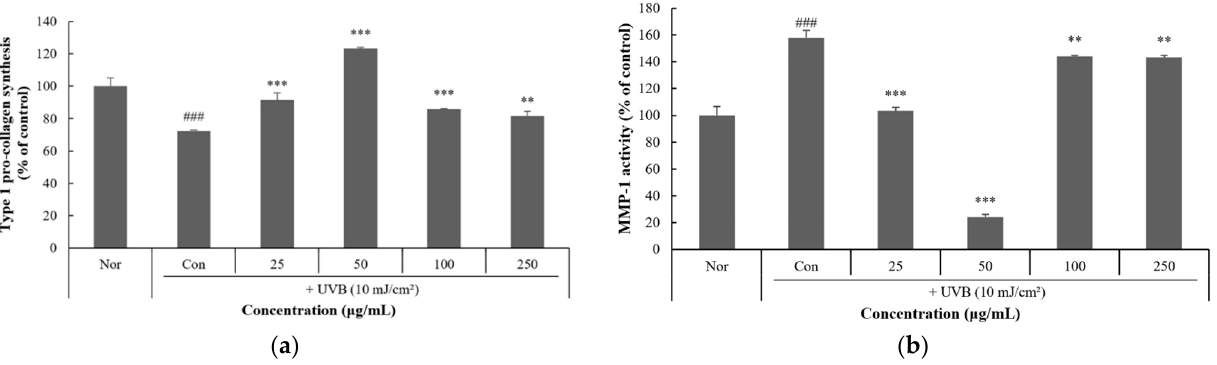
Figure 5. ( a ) Effect of P. thunbergiana L. EtOAc fraction on type-1 procollagen synthesis in UVB- irradiated (10 mJ/cm 2 ) HaCaT cells. ( b ) Effect of P. thunbergiana L. EtOAc fraction on the inhibition of MMP-1 activity in HaCaT cells. ### p < 0.001 compared with the normal control; ** p < 0.01 and *** p < 0.001 compared with the control.